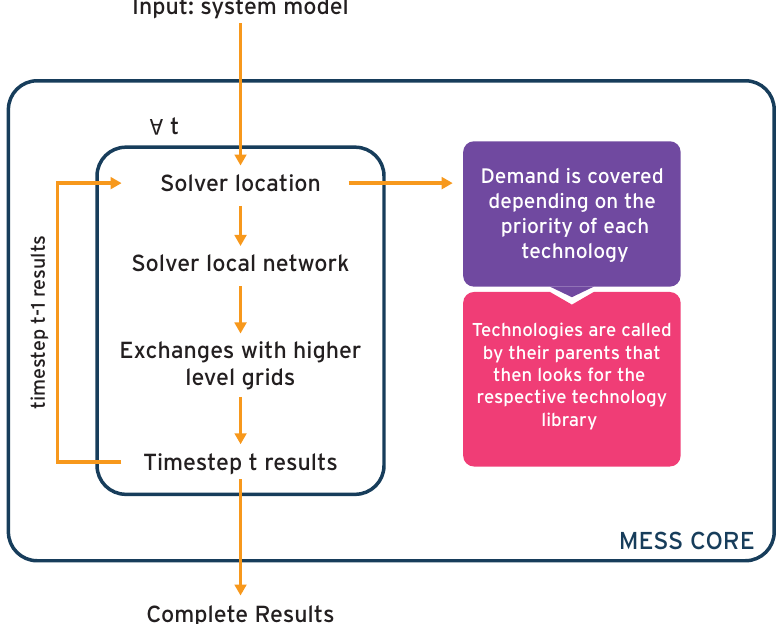
Figure 2. Functioning of the core phase of